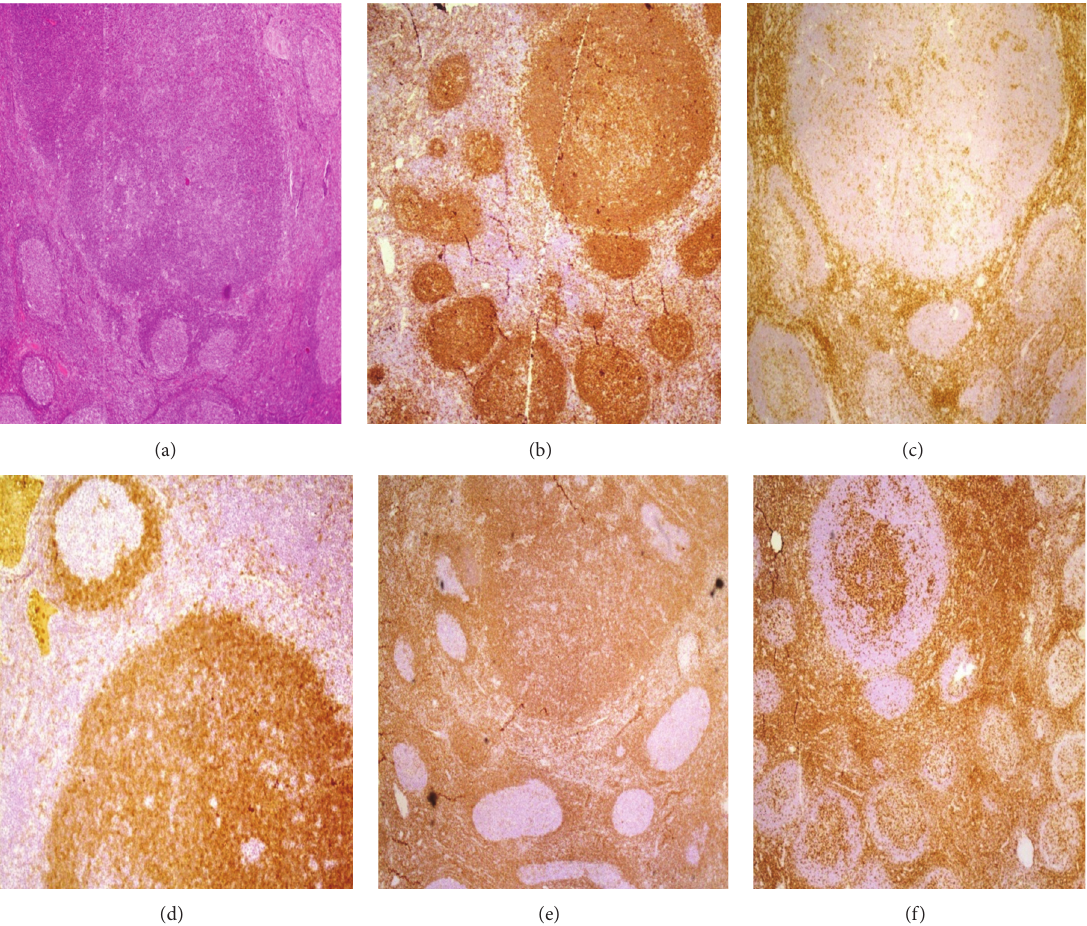
Figure 1: Sections from an enlarged cervical lymph node. (a) Hematoxylin and Eosin staining. (b)–(f) Immunohistochemical staining for CD20 (b), CD5 (c), IgD (d), Bcl-2 (e), and CD43